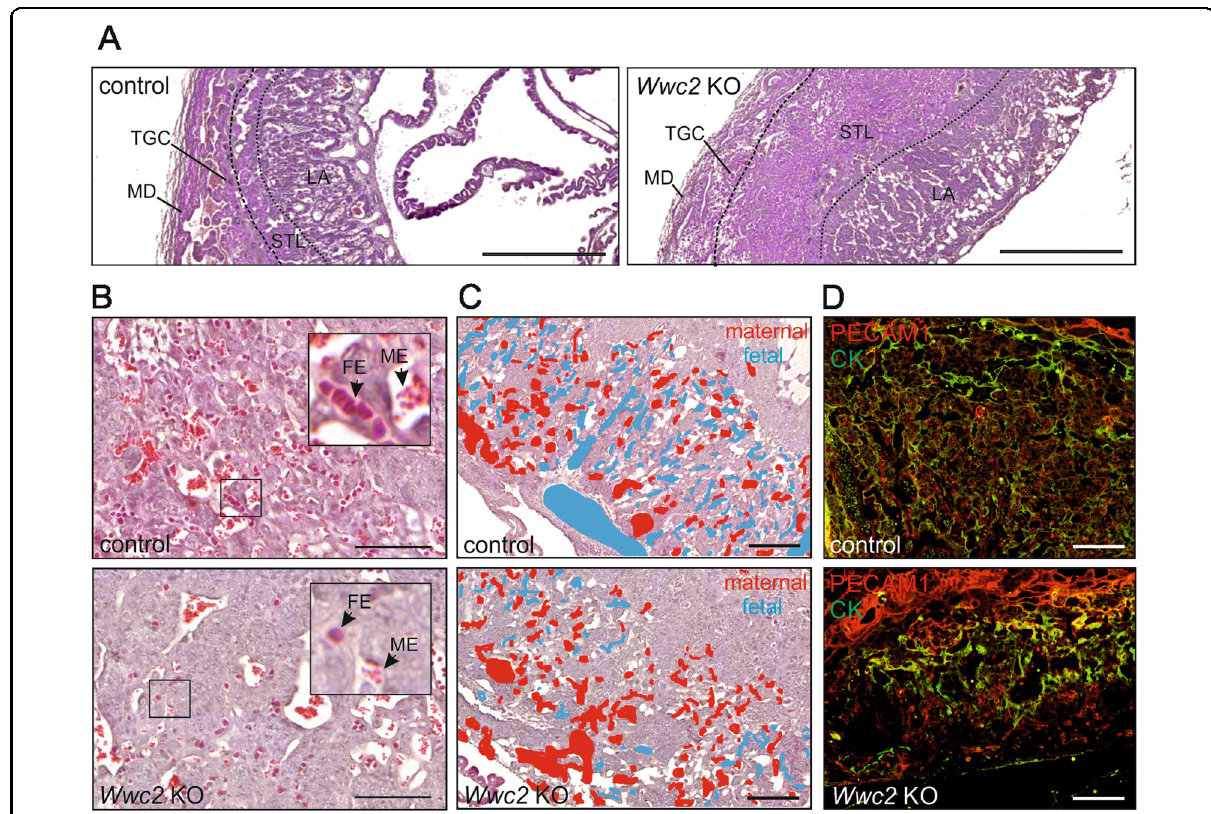
Fig. 2 Defects in placenta organization and impaired labyrinth vascularization in Wwc2 KO embryos. A PAS staining of control and Wwc2 KO placenta at E11.5 indicate a disturbed and unorganized layer formation. MD maternal decidua, TGC trophoblast giant cell, STL spongiotrophoblast layer, LA labyrinth. Dashed lines mark areas of the different tissue layers. Scale bar = 1 mm. B H&E staining of placenta sections were used for the identi fi cation of maternal arterial sinuses and embryonic blood vessels. Insets show a magni fi cation with small, red, non-nucleated maternal erythrocytes (ME) and bigger, purple, nucleated fetal erythrocytes (FE). Scale bar = 100µm. C Labeling of fetal (blue) and maternal (red) erythrocytes indicated a disturbed organization and impaired permeation of fetal blood vessels in the labyrinth system. Scale bars = 200µm. D Immuno fl uorescence staining of sections from control and Wwc2 KO placenta using antibodies against PECAM1 (red; endothelial cell marker) and pan-cytokeratin (CK, green; trophoblast marker) revealed reduced vascularization of the labyrinth. Scale bars =